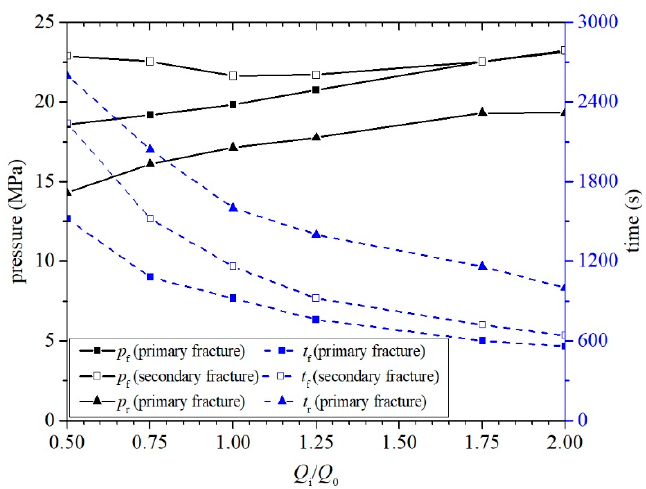
Figure 18. The breakdown pressure/time and reopening pressure/time of fractures in models with different inlet flux.